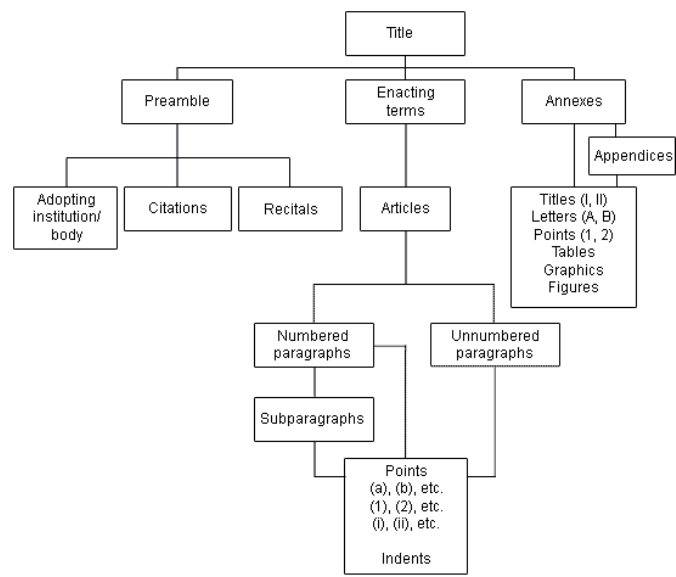
Figure 2. Basic elements of a legal act, according to European Union Interinstitutional Style Guide